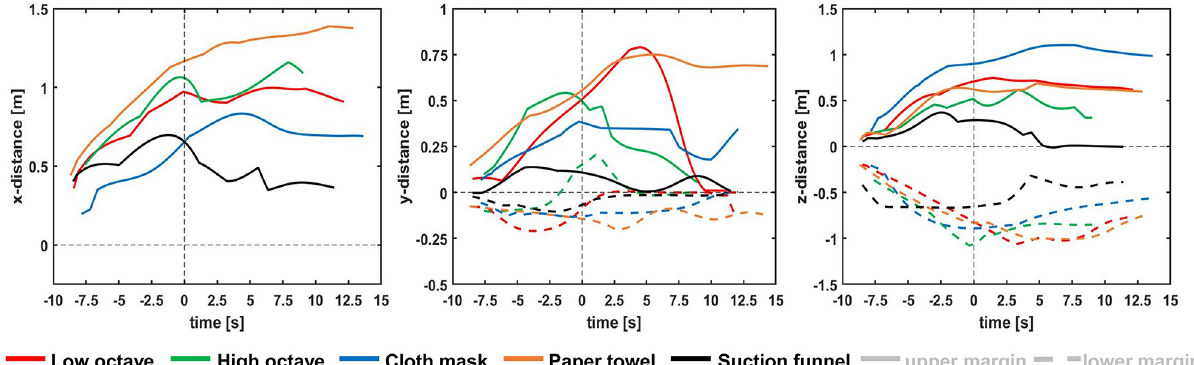
Fig 4. Development of the medians of all three dimensions over time. The zero-point in the time domain marks the end of the phonation task. The distances are measured from the subjects’ mouths.